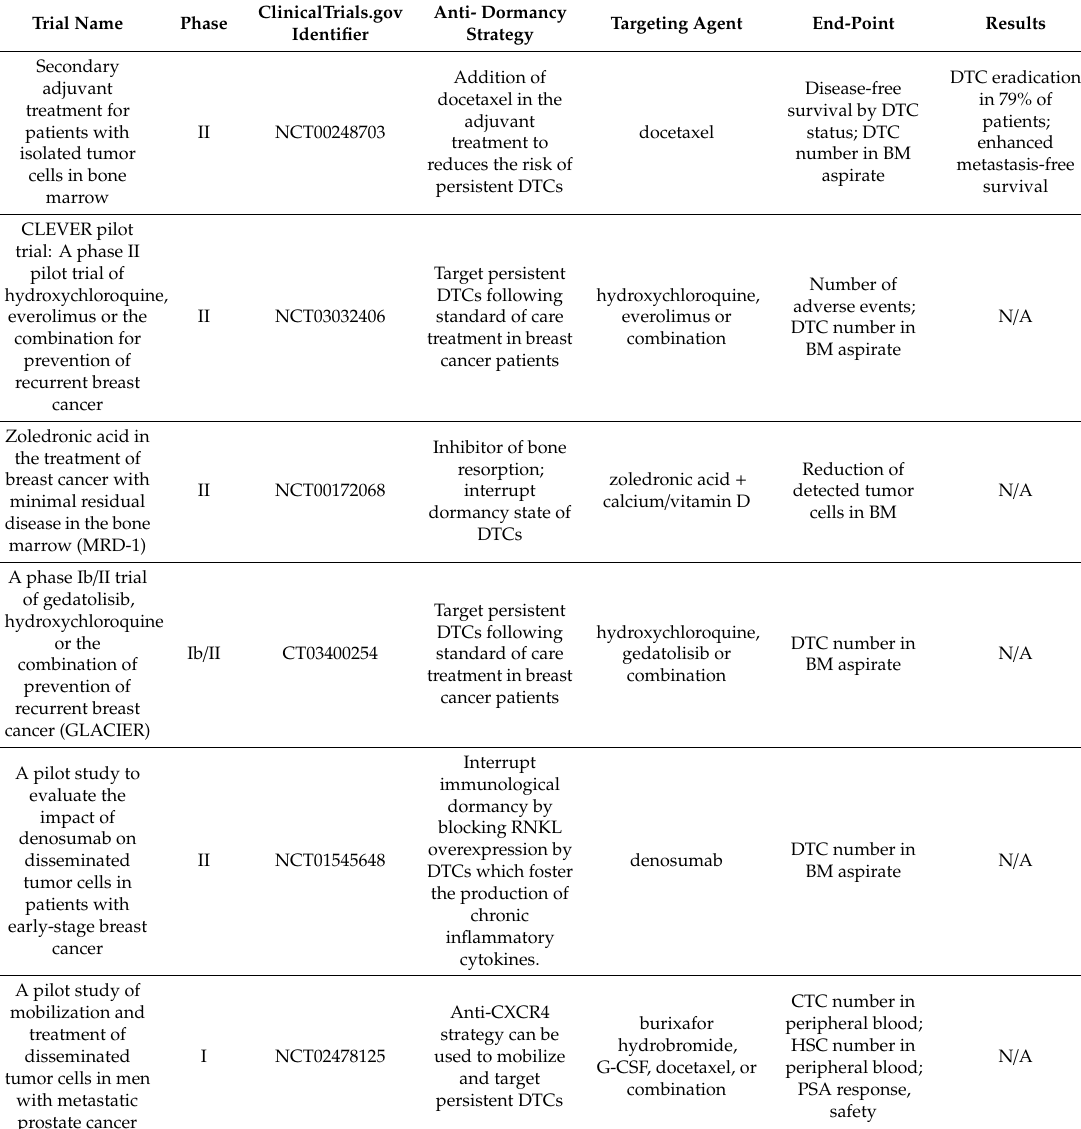
Table 2. Clinical trials targeting persistent DTCs residing in the protective BM